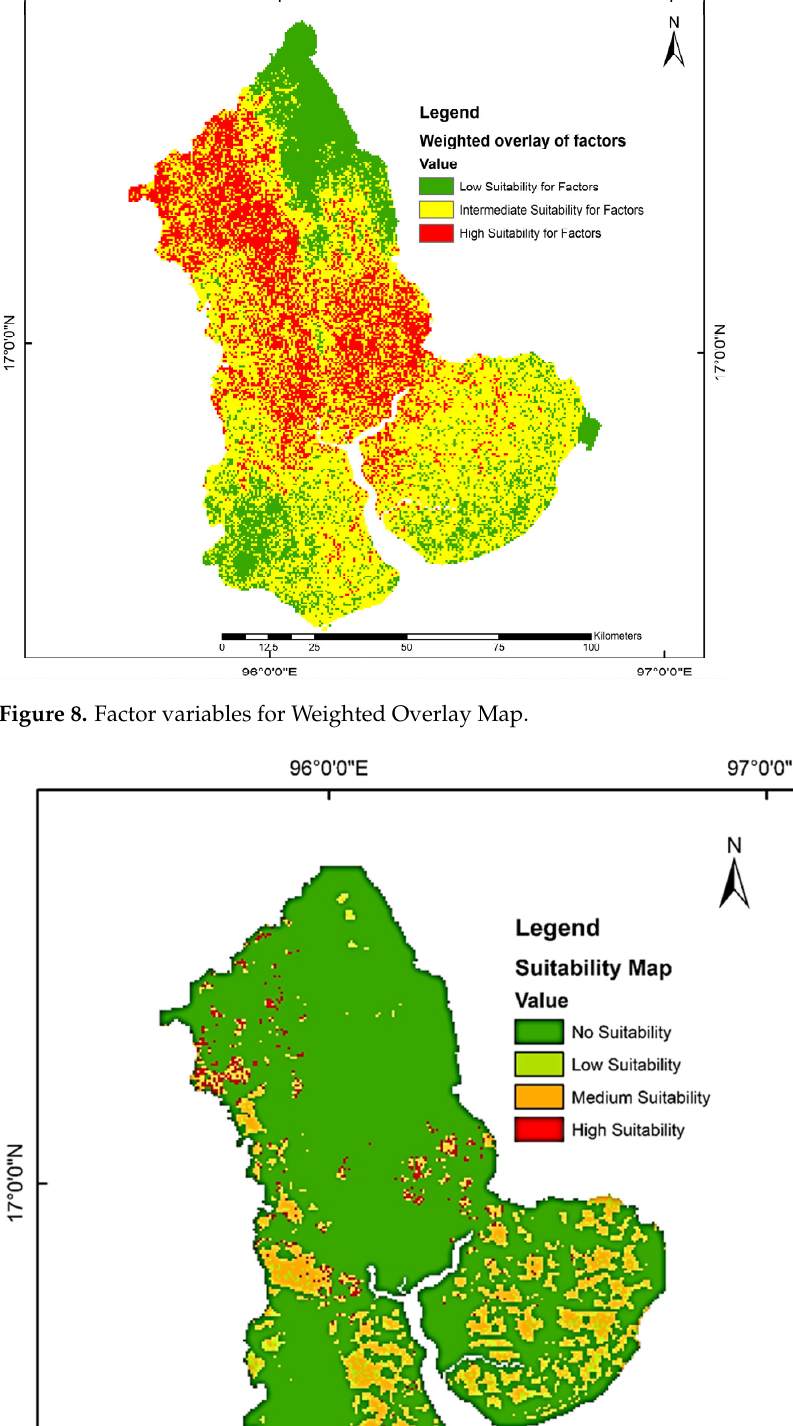
Figure 7. Constraint Variables for Restriction Map.